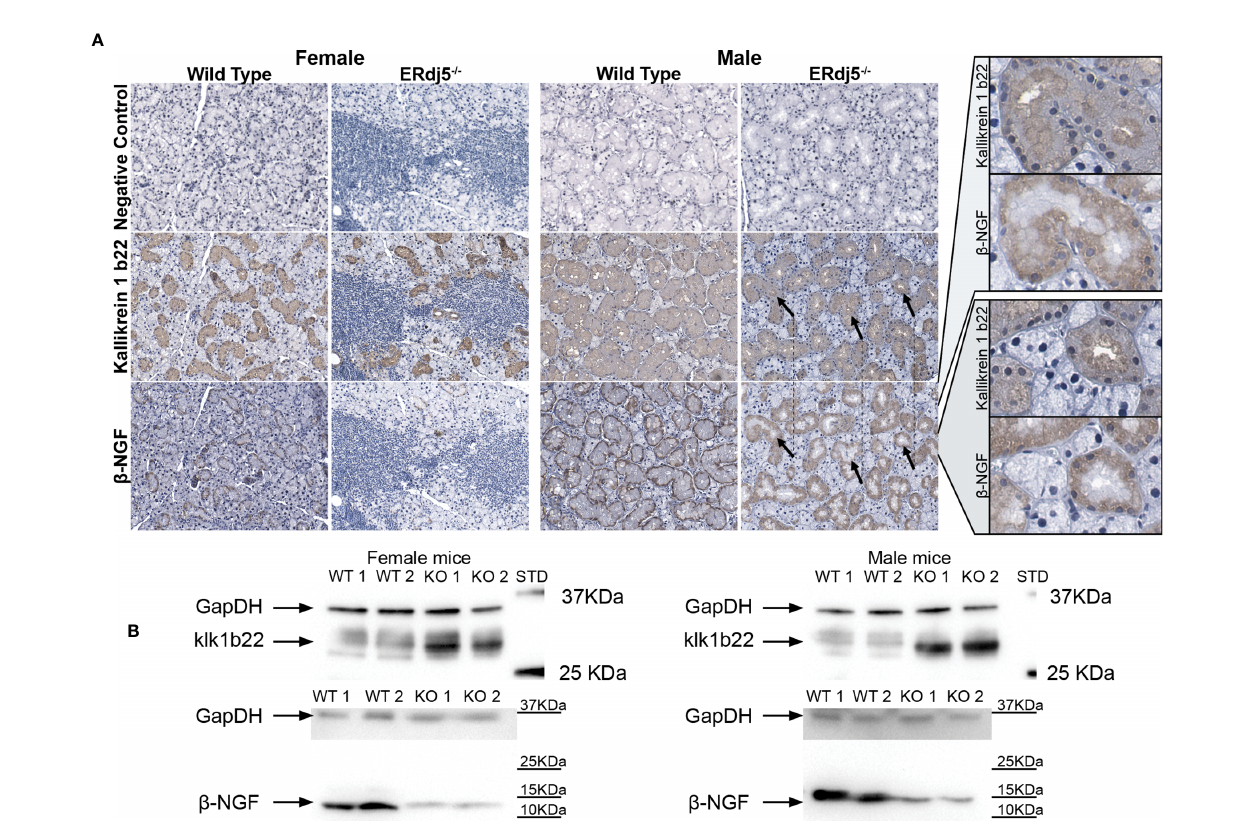
FIGURE 5 | Detection of Kallikrein 1b22 and b -NGF in the murine submandibular salivary gland tissue with antibodies. (A) Representative images (n = 6) of in situ immunohistochemical visualization of kallikrein 1b22 and b -NGF in co-localized paraf fi n sections of murine salivary glands. All mice within groups presented the same respective staining pattern. Negative control sections were treated with Ab diluent without primary Ab, followed by the secondary Ab incubation, DAB and Hematoxylin staining. Positive signal: Brown, counterstain: Blue, hematoxylin. The black arrows indicate the same tissue regions in different stains, where the positive signal for kallikrein 1b22 coincides with a lack of positive stain for b -NGF. Rightmost column: Increased magni fi cation of these regions for both Kallikrein 1b22 and b -NGF. (B) Representative western blot images (n = 6) for the detection of Kallikrein 1b22 (approximately at 28kD) and b -NGF (approximately at 12kD). Samples for female and male mice were run at individual gels in the case of kallikrein 1b22, and in the same gel but with different exposure times for each sex in the case of b